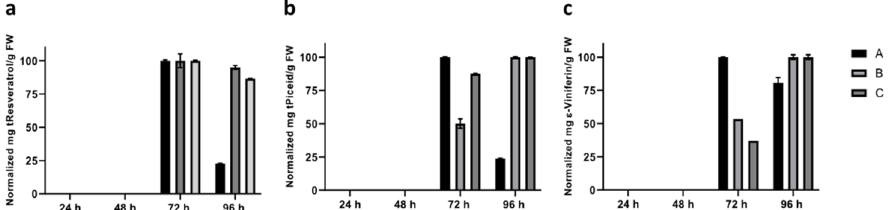
Figure 4. CD elicitation of intact Gamay leaves induced stilbene accumulation. Time-course of stilbenes accumulation in Gamay leaf treated with 50 mM of CD. The stilbenes tR ( a ), tPiceid ( b ) and ε-Viniferin ( c ) were detected in elicited leaves of three independent Gamay plants (A, B, and C). For a better comparison, the abundance of each compound was normalized to the highest value in each plant: % compound X in plant Y = mg/g FW of compound X in plant Y × 100/highest value of mg/g FW of compound X in plant Y. Error bars correspond to MRM analysis of three technical replicates.